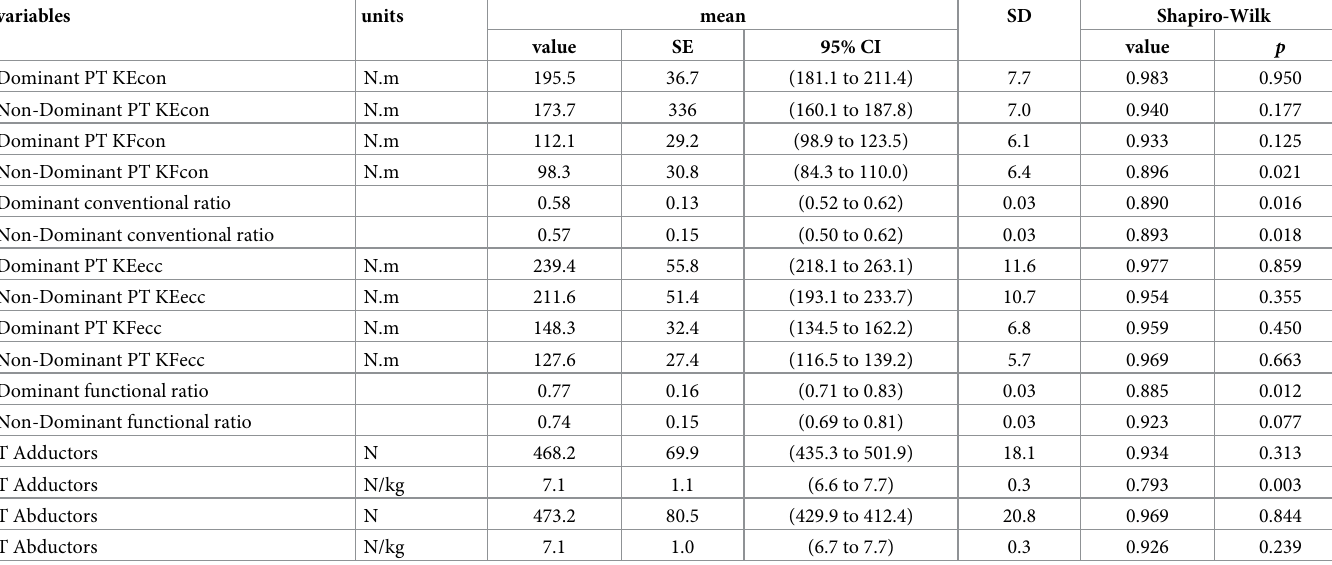
Table 2. Descriptive statistics and normality test for the total sample considering strength parameters (n = 23).